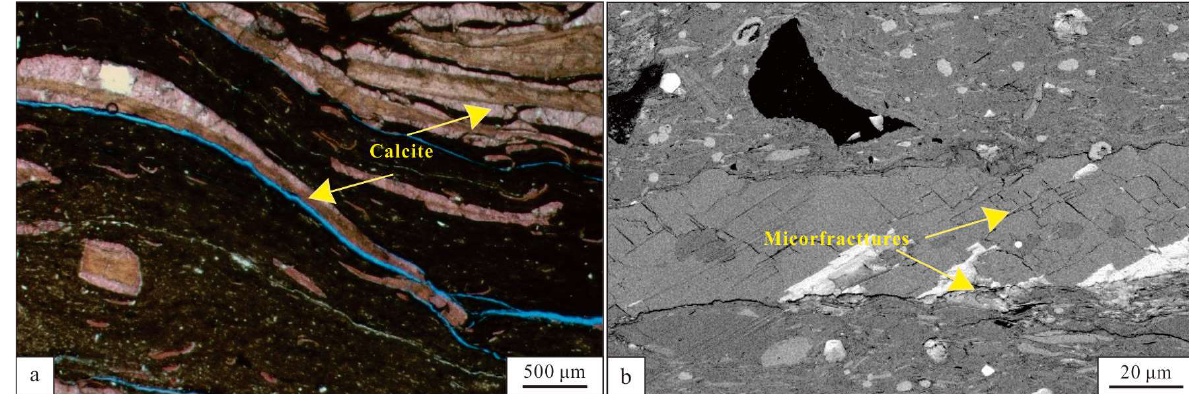
Figure 6. Comparison Diagram of Mineral Composition of Wufeng Formation–Longmaxi Formation Marine Shale and Da’anzhai Member Continental Shale: ( a ) Wufeng Formation–Longmaxi Formation, ( b ) Da’anzhai Member.